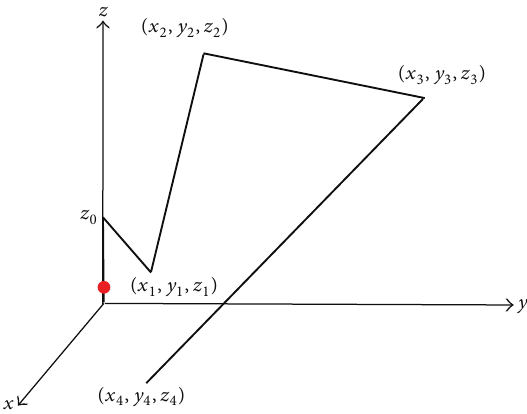
Figure 2: Geometric structure of the antenna in the first quadrant. regularly spaced elements), wire antennas, horn antennas, and microstrip and patch antennas. Each of these classes uses different structures and exploits different properties of electromagnetic